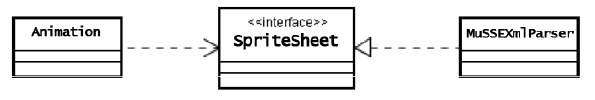
Fig. 24. Class Diagram for a possible